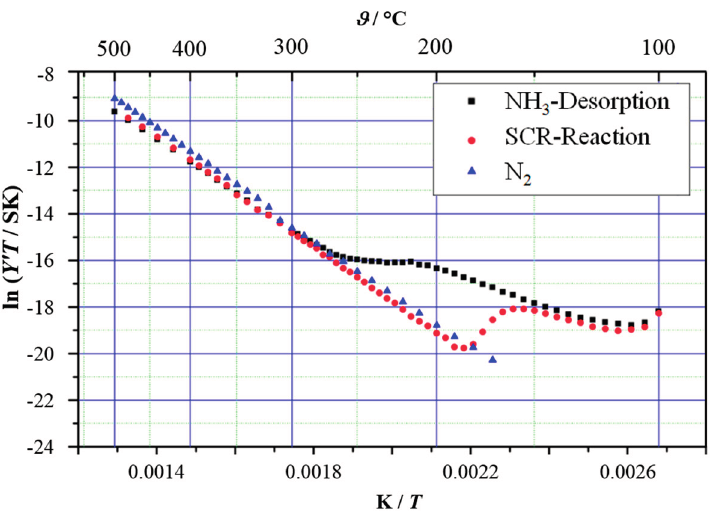
Figure 12. Arrhenius-like representation of the conductance as obtained by IS measurements over H-ZSM-5 zeolite (Zeolyst: Conshohocken, PA, USA; Si/Al = 80) under different gas conditions (stars: thermal desorption, i.e ., NH 3 -solvated zeolite in N 2 ; circles: SCR, i.e ., NH 3 -solvated zeolite in NO/O 2 mixture; triangles: reference, i.e. non-solvated zeolite in N 2 .). Adapted from [25] with permission from Cambridge University